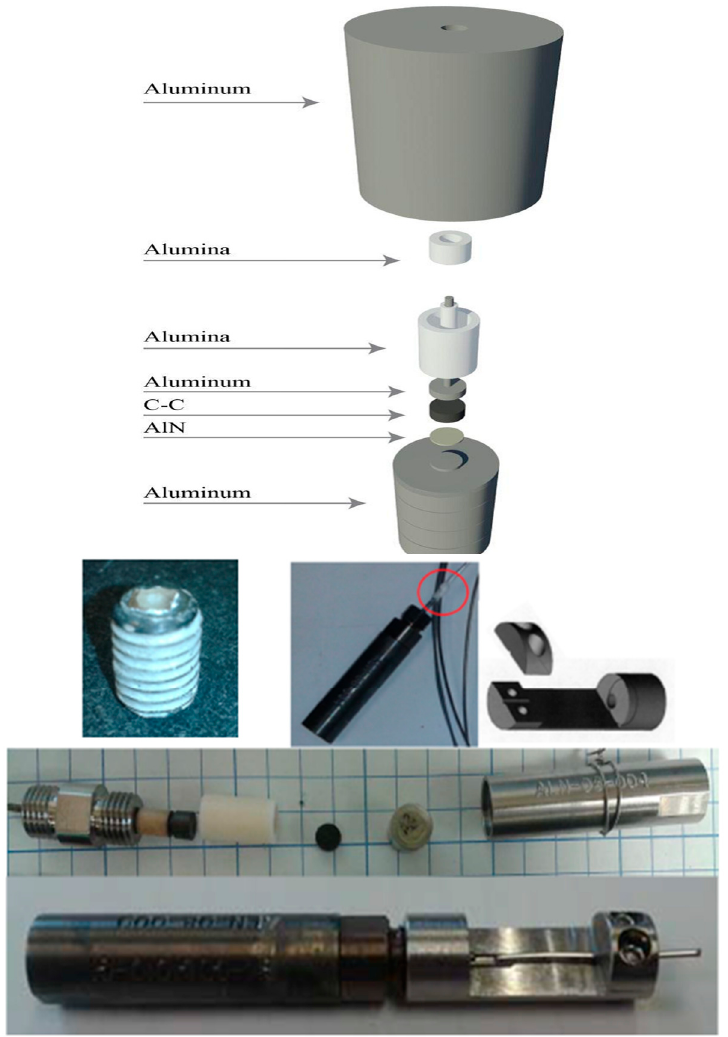
Figure 8. Photos of the fixture inserted into the Massachusetts Institute of Technology (MIT) reactor [31]. Table 4. MIT research reactor environment.